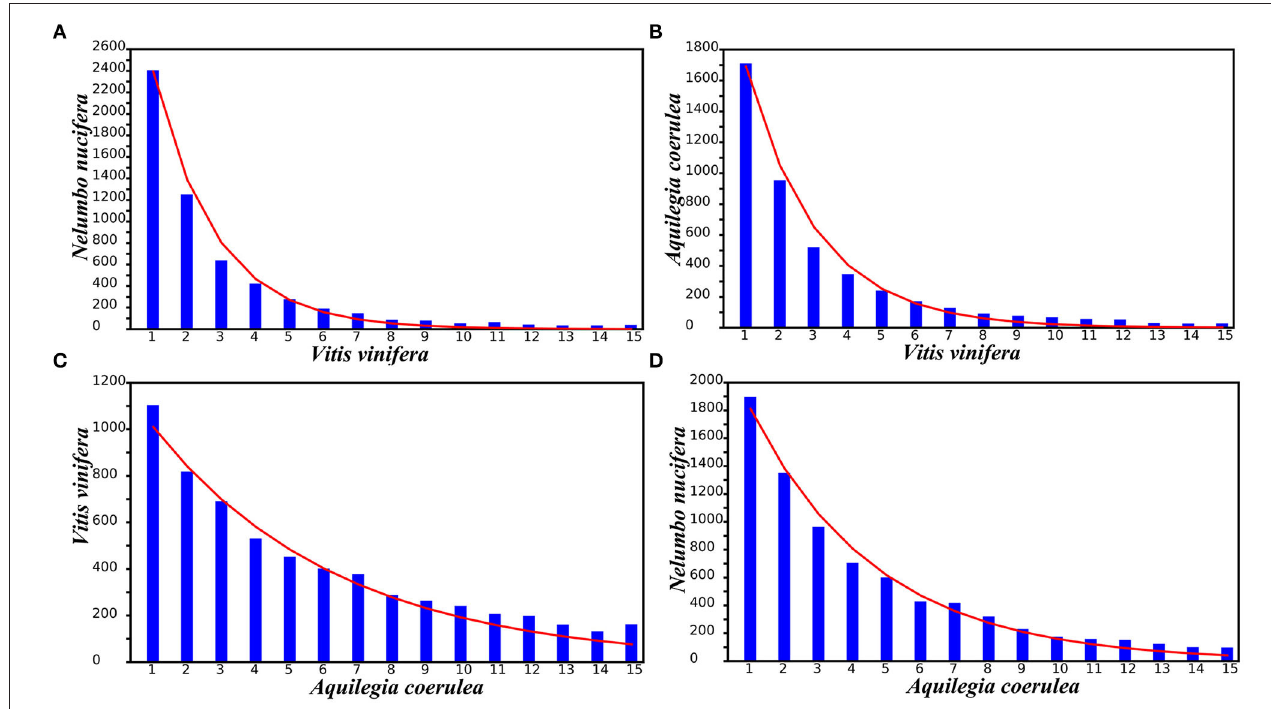
FIGURE 5 | Geometric distributions of gene loss rates fitting: (A) N. nucifera to the V. vinifera genome, (B) A. coerulea to the V. vinifera genome, (C) V. vinifera to the A. coerulea genome, and (D) N. nucifera to the A. coerulea genome. The x-axis indicates numbers of continuously missing genes in gene collinearity